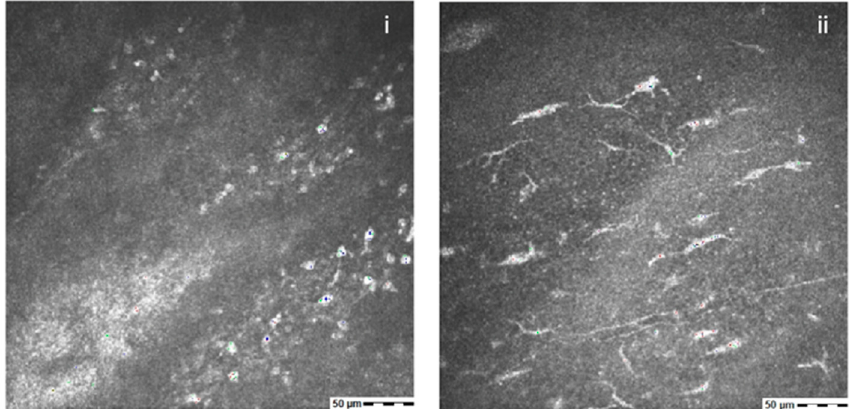
Figure 3. IVCM in a patient with post-herpetic NK shows no sub-basal nerve fibers at baseline ( i ). After 8 weeks of the treatment with rh-NGF, the presence of nerves can be detected ( ii ).